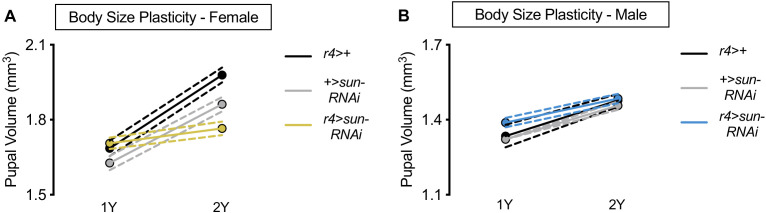
Nutrient-dependent increased female body size plasticity requires stunted (sun).(A) Pupal volume was significantly higher in r4>+, +>UAS-sun-RNAi, and r4>UAS-sun-RNAi females reared on a protein-rich diet (2Y) compared with genotype-matched females cultured on a diet with half the protein (1Y) (p<0.0001 [r4>+ and +>UAS-sun-RNAi] and p=0.0367 [r4>UAS-sun-RNAi]; two-way ANOVA followed by Tukey HSD test). The magnitude of the nutrient-dependent increase in pupal volume was significantly lower in r4>UAS-sun-RNAi females (genotype:diet interaction p<0.0001; two-way ANOVA followed by Tukey HSD test). n = 69–80 pupae. (B) Pupal volume was significantly higher in r4>+, +>UAS-sun-RNAi, and r4>UAS-sun-RNAi males reared on 2Y compared with genotype-matched males cultured on 1Y (p<0.0001 for all genotypes; two-way ANOVA followed by Tukey HSD test). The magnitude of the nutrient-dependent increase in pupal volume was not significantly different between r4>UAS-sun-RNAi males and control males (genotype:diet interaction p=0.0784; two-way ANOVA followed by Tukey HSD test). n = 44–80 pupae. For body size plasticity graphs, filled circles indicate mean pupal volume, and dashed lines indicate 95% confidence interval.